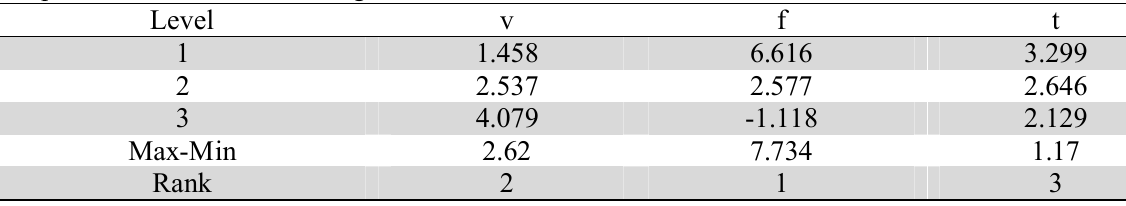
Main Effects Plot (data means) for SN ratios